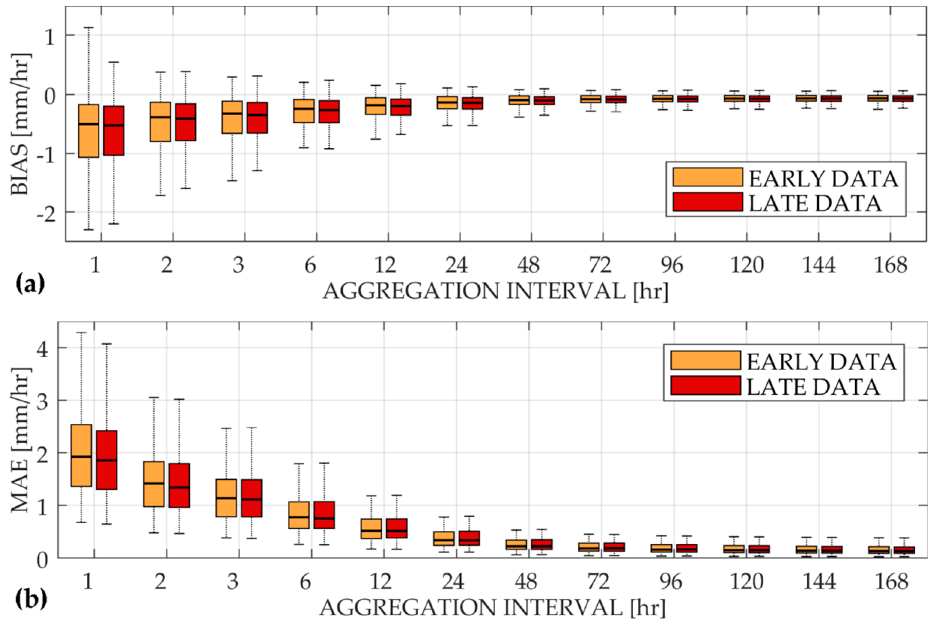
Figure 2. The bias ( a ) and mean absolute error (MAE) ( b ) evaluated for nonzero rainfall intensities: The orange boxplot refers to the GPM IMERG half-hourly early data while the red boxplot refers to the GPM IMERG half-hourly late data. Table 2. The bias and MAE values calculated taking into account only the nonzero rainfall intensities both for the early (E) and for the late (L) products. 1 h 2